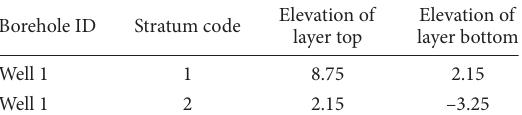
Figure 4: The step-by-step coarsen of layer information of bore- hole